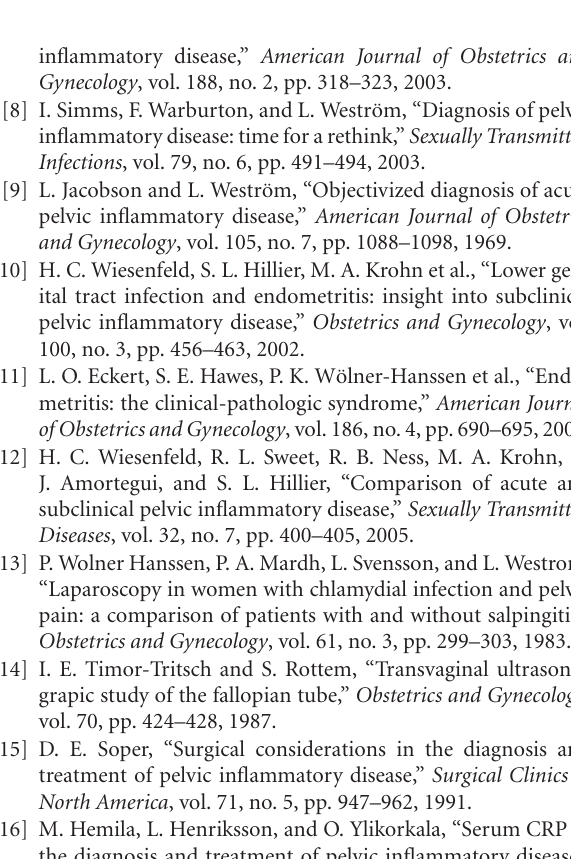
Figure 1: Flow chart Showing Clinical Diagnosis of